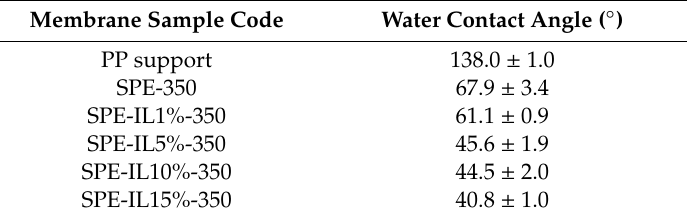
Table 2. Water contact angles for IL-HCMs prepared at 350- µ m film solution with di ff erent amounts of IL.